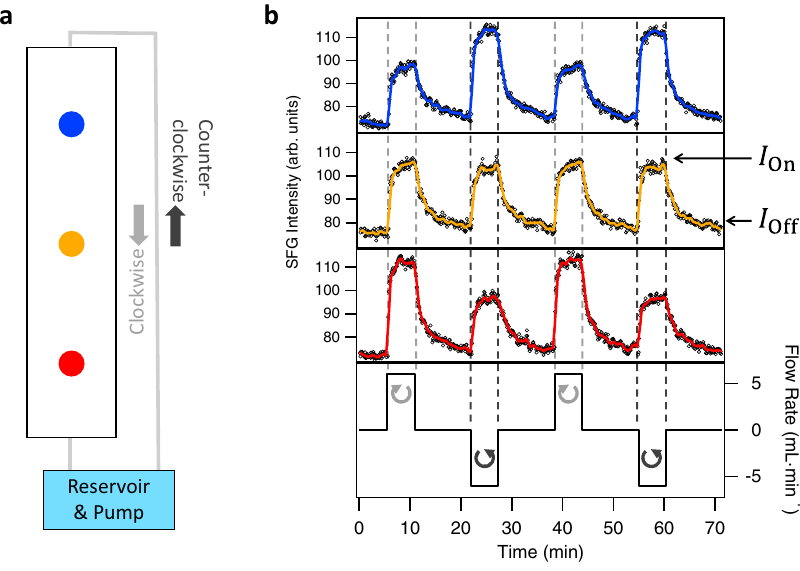
Fig. 2 Position and fl ow direction-dependent change in the v-SFG response upon fl ow. a Schematic representation of the fl ow set-up. The aqueous solution reservoir ( (cid:4) 100 mL of a 1 mM NaCl and HCl (pH 3) solution) is pumped via tubes and the fl ow cell using a peristaltic pump. The fl ow channel is 24.8 mm long, 4.3 mm deep, and 4.8 mm wide. The fl ow direction can be changed from clockwise to counterclockwise. The v-SFG spectra were recorded at three spots in the channel. One spot in the center (yellow) and two points separated by 8 mm from the center in the two directions of the fl ow channel (blue and red, respectively). b Time trace of integrated SFG spectra (black circles) at the interface of the solution and calcium fl uoride for several fl ow on – off cycles (black curve). As indicated by the arrows and the different signs of the fl ow rate, different fl ow directions were employed. The colored solid lines are ten-point averages to guide the eye and highlighting at which spot in the fl ow channel the spectra were recorded. For the time trace measured at the center, the intensity levels of the spectra with ( I on ) and without fl ow ( I off ) are highlighted by arrows.